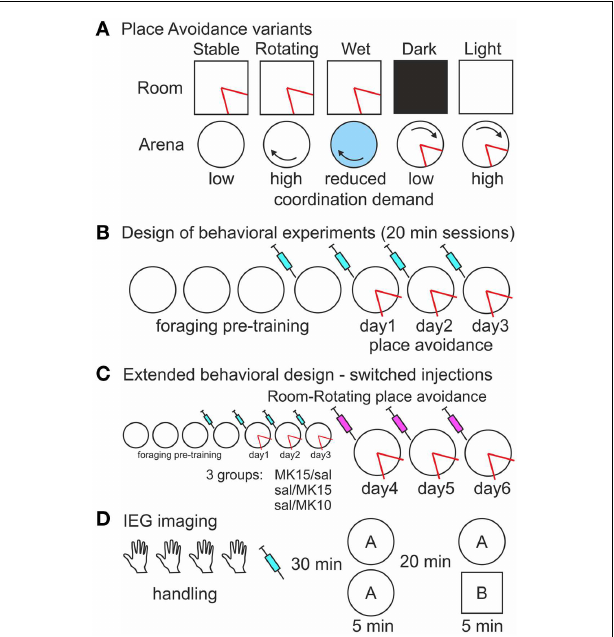
FIGURE 2 | Experimental design (A) . A schematic of five versions of the place avoidance task. All spatial cues are relevant and the demand for cognitive coordination is low during room-defined avoidance on the Stable arena when the arena rotation is off. In contrast, the room and arena cues are dissociated on the Rotating arena resulting in a high coordination demand. Cues on the arena surface are hidden by shallow water, but the arena-bound idiothetic cues can still interfere with the avoidance, and the demand for coordination is reduced on theWet arena.The cognitive coordination demand during arena-based avoidance is low when irrelevant room cues are hidden by Darkness and high when they are available in Light.The shock zone (red) is defined in one reference frame (B) . Design of the place avoidance experiments.The rats were pre-trained to forage on the arena prior to the place avoidance training. Saline or MK-801 was administered 30min before the session starting from the last day of foraging (C) . Extended place avoidance training design. After 3days of Room-Rotating training, injections were switched so that rats initially trained with MK-801 (0.15mg/kg) received saline (MK15/sal) and rats initially trained with saline received MK-801 at 0.15mg/kg (sal/MK15) or 0.10mg/kg (sal/MK10).The extended training continued for 3days. (D) . Design of the IEG imaging experiment. Rats received four handling sessions (5min), an injection of saline or MK-801, and two exploration sessions in environment (A) or in environments (A,B)